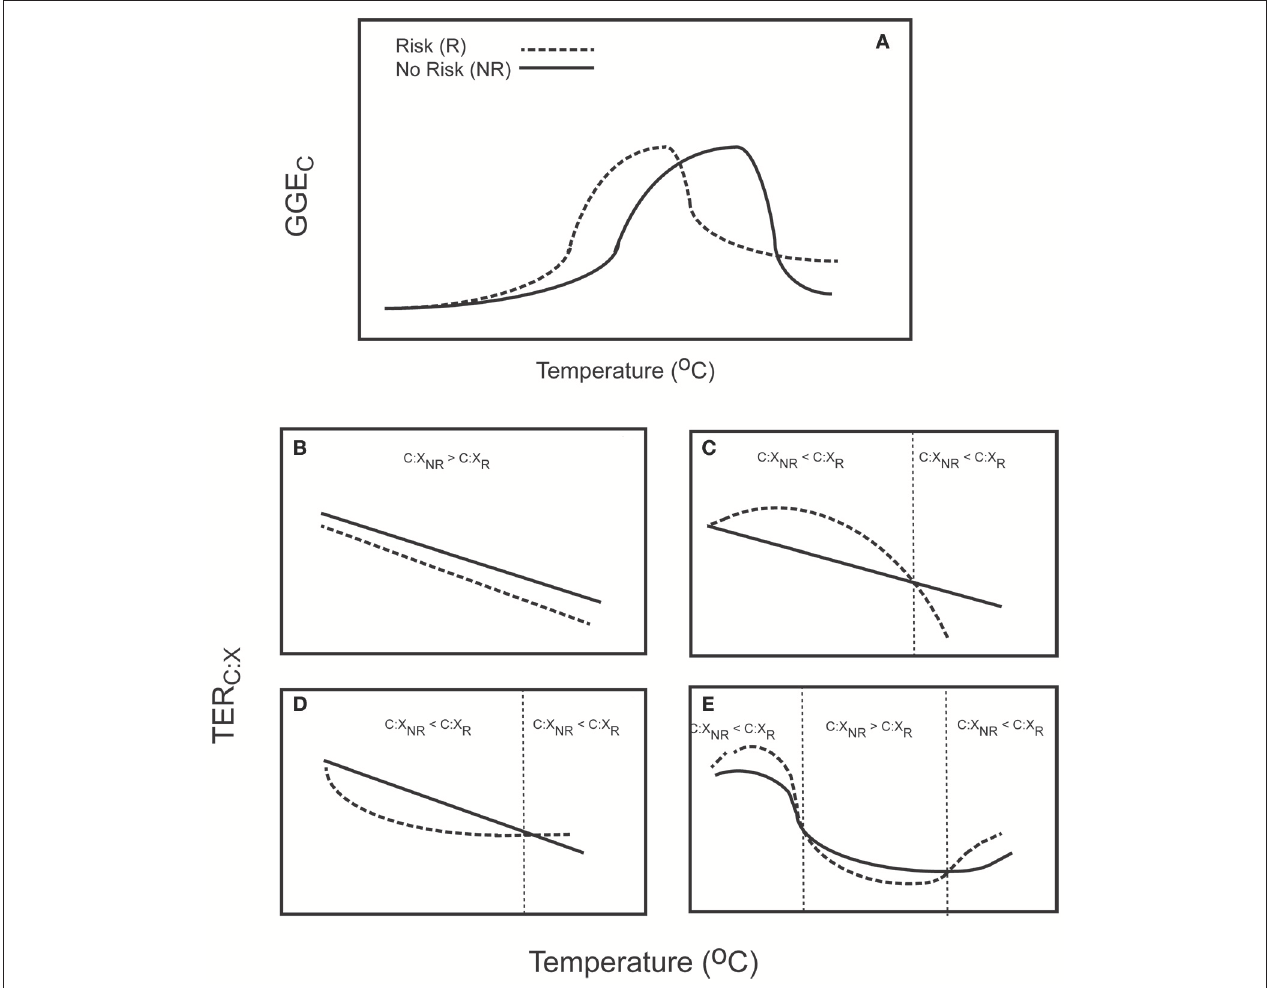
FIGURE 2 | The temperature sensitivity of prey to perceived predation stress and implications for intake of dietary C and N based on functional relationships depicted in Figure 1 . (A) Gross growth efficiency ( GGE C ) varies nonlinearly with temperature, but perceived predation risk offsets the curve relative to no-risk conditions. (B–E) The temperature sensitivity of the threshold elemental ratio TER, determined by the ratio of assimilation efficiency of N/GGE C , is contingent on assumptions about how assimilation efficiency A X varies with temperature. The depictions assume that A X is constant for both risk and risk free conditions (B) , is constant for risk free conditions but increases linearly with temperature for risk conditions (C) , is constant for risk free conditions but decreases linearly with temperature for risk conditions (D) , and changes nonlinearly (increasing and then decreasing) across a temperature gradient for both risk and risk free conditions (E) . The figure shows temperature thresholds (vertical dotted lines) where prey facing risk would consume more N than no risk prey ( C:X NR > C:X R ), and when prey facing risk should consume more C than no risk prey ( C:X NR < C:X R ). The figure illustrates that consumption ratios are highly dependent on the temperature conditions in which prey risk responses are